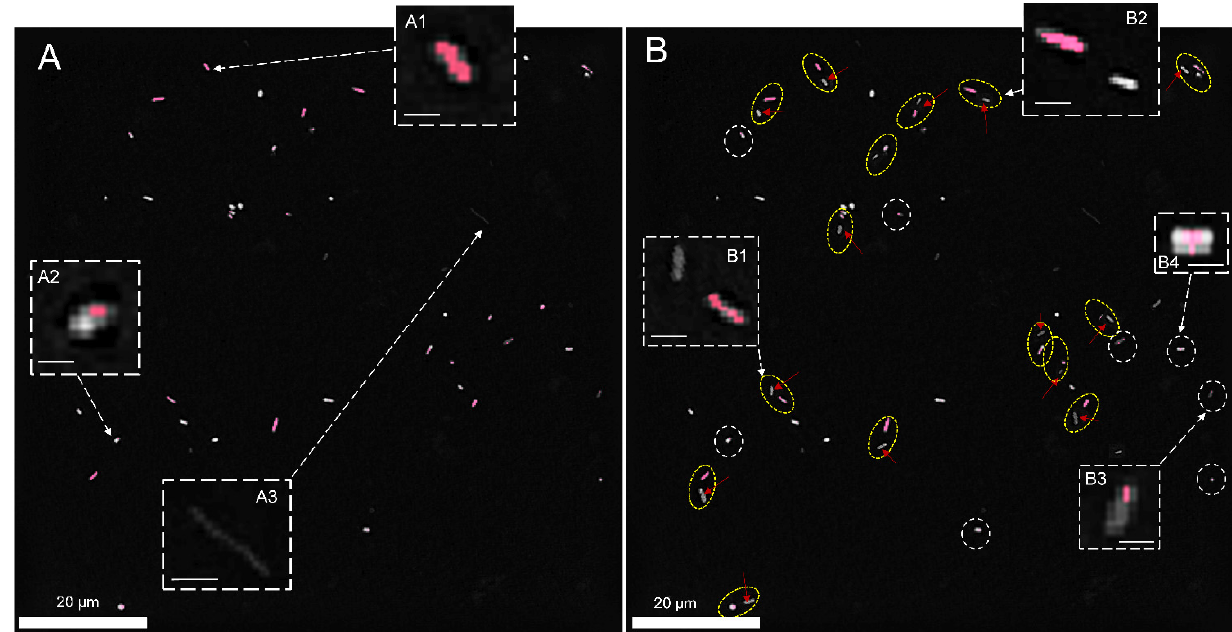
Figure 7. The 2D-RI maps with digitally stained cells of E. coli: ( A ) 8 h after photoexcitation and ( B ) 10 h after photoexcitation. Red-stained cells had RI values changing in the range from 1.368 to 1.375. The yellow ellipses indicate the stained cells, in which neighborhood the additional cells (indicated by red arrows) appear after the cell’s division. The white circles indicate initially stained cells, which turned out to be incapable of division after 2 h of the beginning of the examination. Red arrows indicate new cells not present 2 h earlier. A1–A3, B1–B3 are representative enlarged 2D-RI maps of cells (detailed description in text). The white scale bars for A1–A3, B1–B3 are equal to 2 µm.